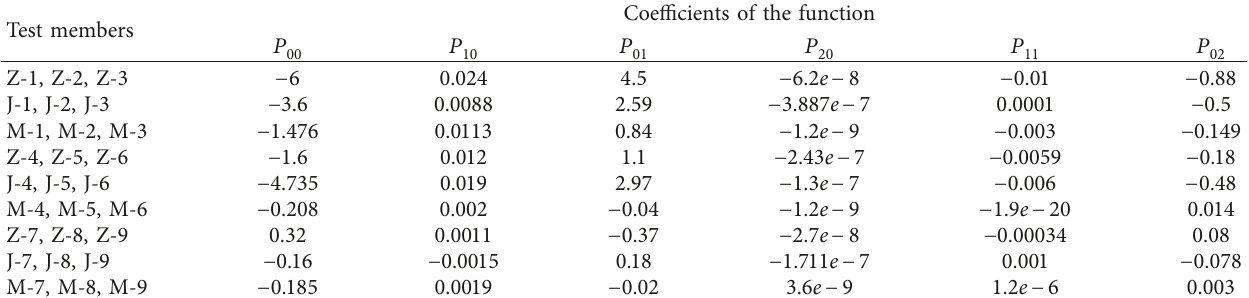
Figure 10: Damage-rate fitted surfaces of ( V ), ( N ), ( T ). (a) Z-1, Z-2, Z-. (b) J-1, J-2, J-3. (c) M-1, M-2, M-3. (d) Z-4, Z-5, Z-6. (e) J-4, J-5, J-6. (f) M-4, M-5, M-6. (g) Z-7, Z-8, Z-9. (h) J-7, J-8, J-9. (i) M-7, M-8, M-9. Table 6: Coefficients of function of V ( N, T )